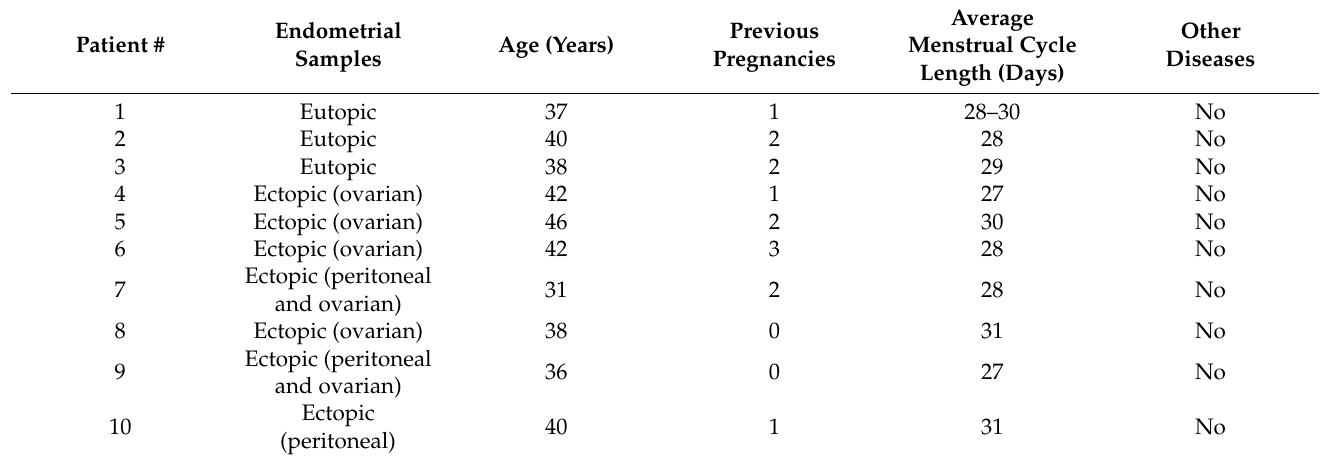
Table 1. Demographic and clinical characteristics of patients enrolled in the